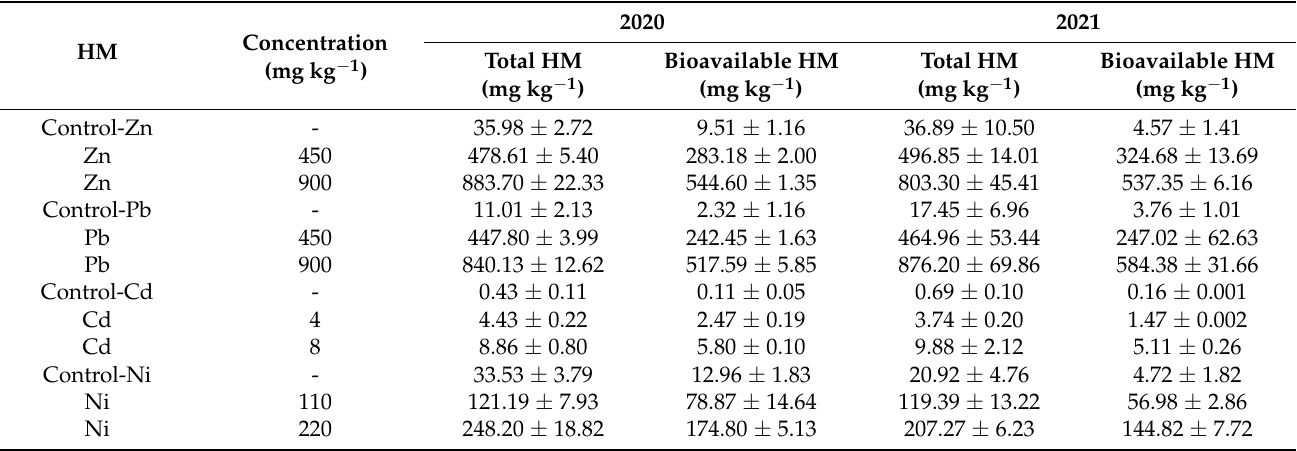
Table 3. The total and bioavailable heavy metals (HM) concentration in the contaminated and control